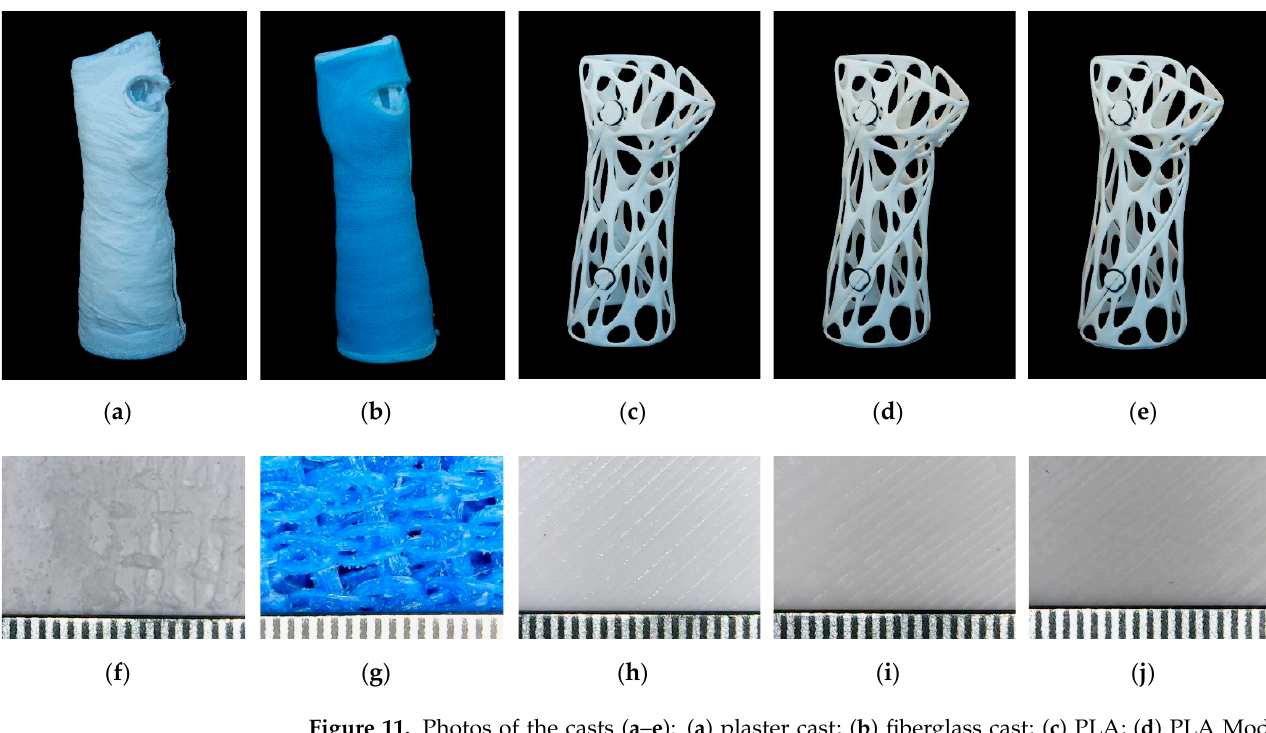
Figure 11. Photos of the casts ( a – e ): ( a ) plaster cast; ( b ) fiberglass cast; ( c ) PLA; ( d ) PLA Model; ( e ) PLA Gypsum; ( f – j ) video microscopic image of the surfaces of the casts, with a ruler with mm scale at the bottom of the pictures; ( f ) plaster cast’s surface, where the white gypsum shows the gauze fibers that stiffen the casting; ( g ) fiberglass cast’s surface, showing a woven model of the fiberglass cast; ( h ) PLA’s surface; ( i ) PLA Model’s surface; ( j ) PLA Gypsum’s surface; ( h – j ) the surface is typical for the FFF 3D-printed thermoplastic materials, and the striping is due to extrusion.